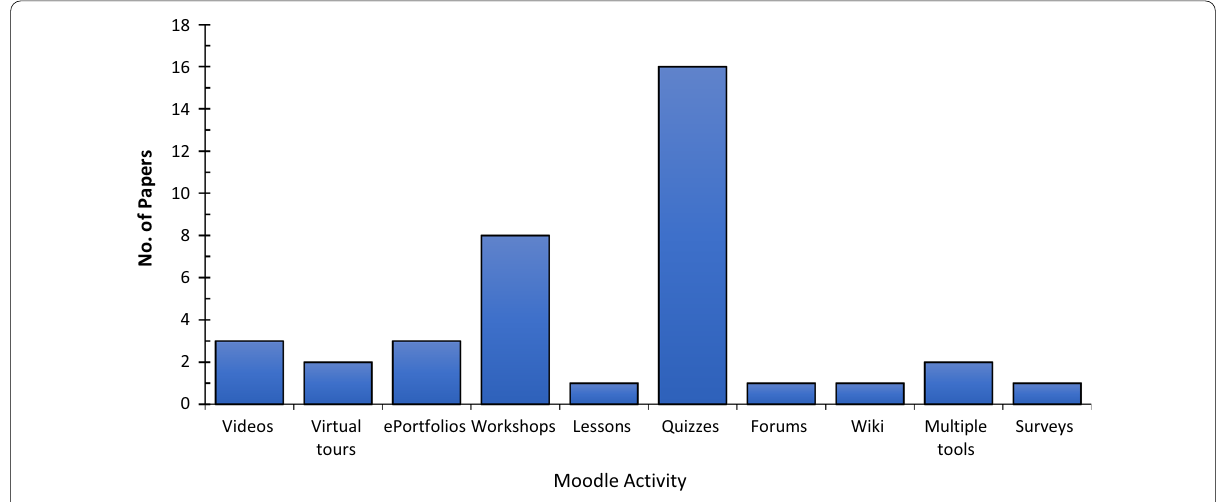
Fig. 8 Number of articles reporting research on each Moodle